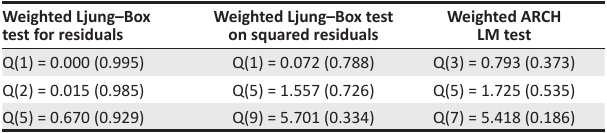
TABLE 4b: South Africa – Specification for the rate of change of forex reserves to M1 ratio: A GARCH[1,1] model. Weighted Ljung–Box test for residuals